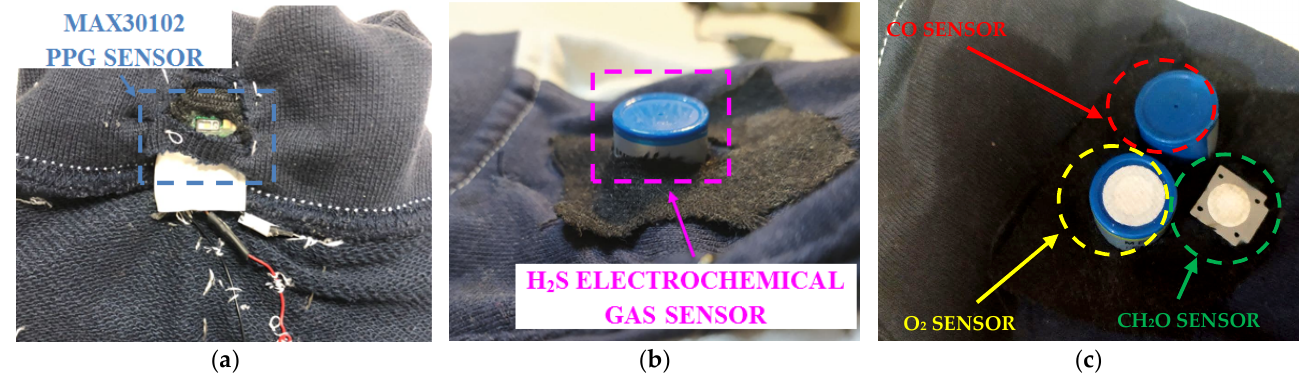
Figure 7. Details of the smart garment: MAX30102 PPG sensor fixed on the sleeve ( a ) and electro- chemical gas sensors placed on the shoulders: H 2 S ( b ) and multisensor ( c ) modules.